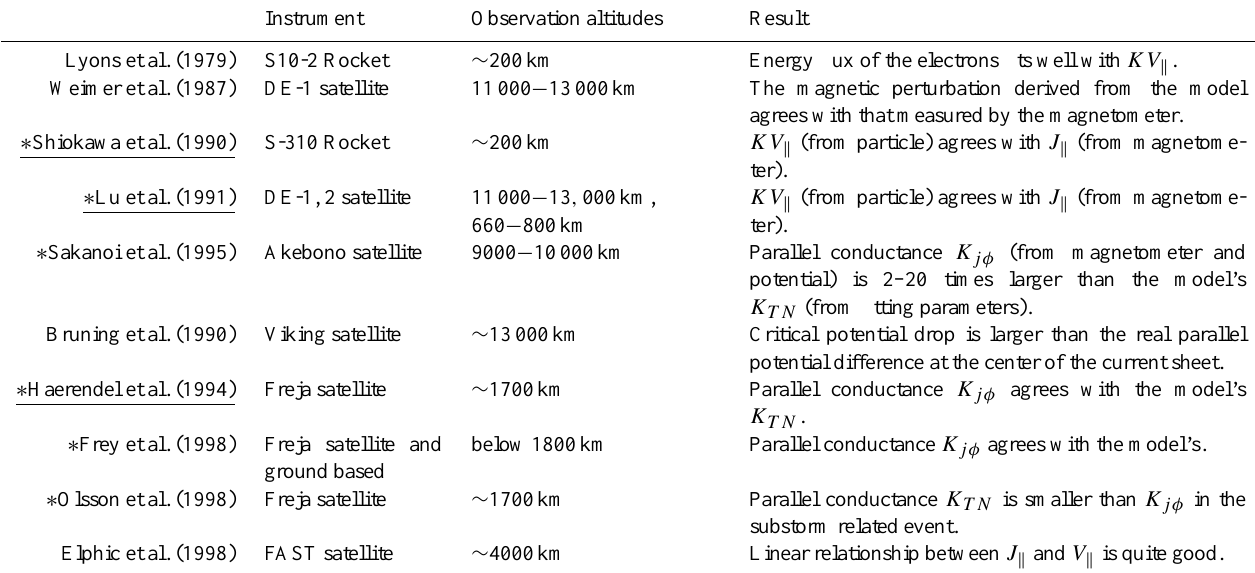
Table 1. Summary of previous studies about the current-voltage relationship in the upward field-aligned current region. The marked papers have examined ( ∗ ) the Knight’s current-voltage relationship directly using particle data. Underlined papers have reported agreement with Knight’s